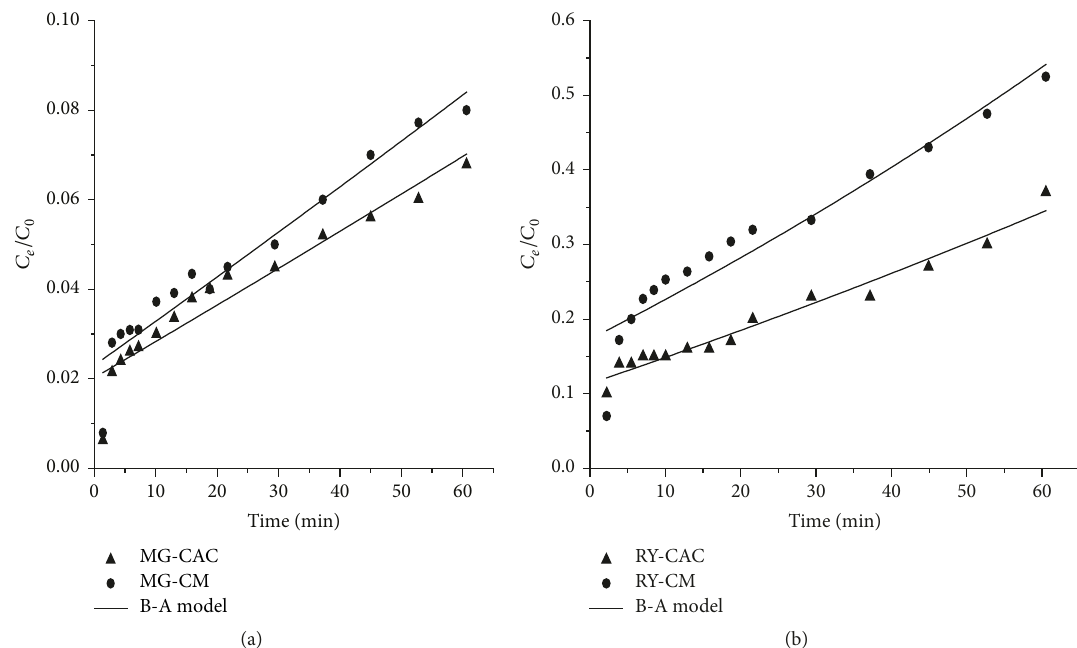
Figure 6: Comparison of fitted curves and experimental data using the Bohart-Adams model for the adsorption of (a) malachite green and (b) Remazol yellow using CAC and CM ( ℎ = 17 cm).